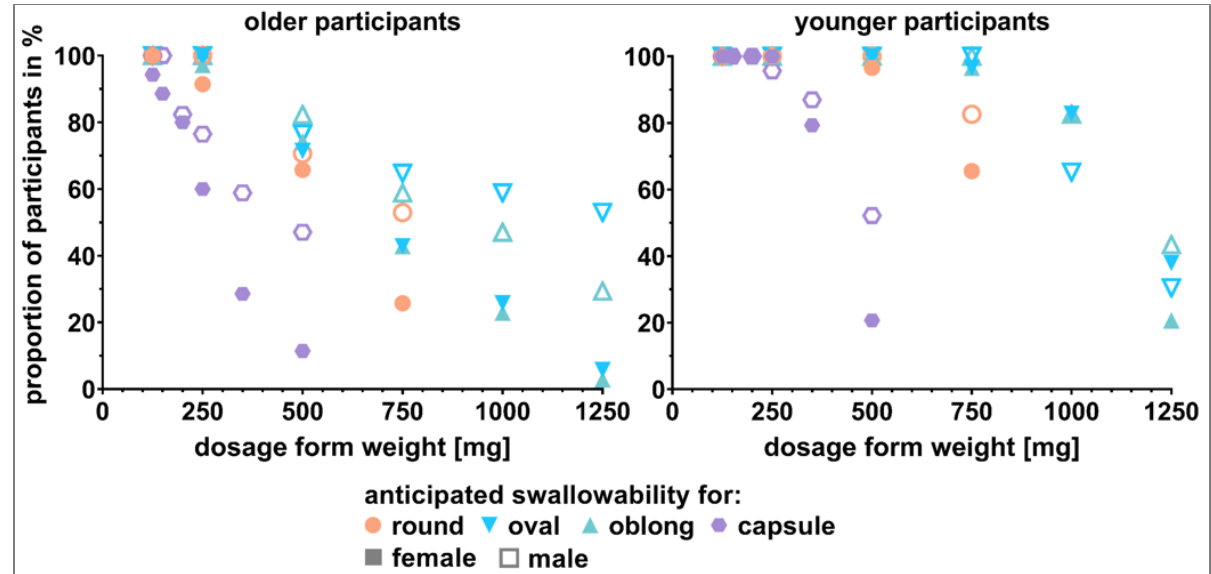
Figure 9. Influence of sex on the visual perception of the swallowability of the dosage forms presented within the shape-showcases. Data are shown separately for older participants (67.3% female; left panel) and younger participants (55.8% female; right panel).